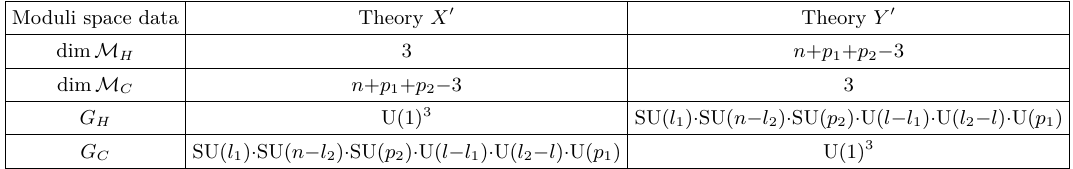
Table 6 . Summary table for the moduli space dimensions and global symmetries for the mirror pair in figure